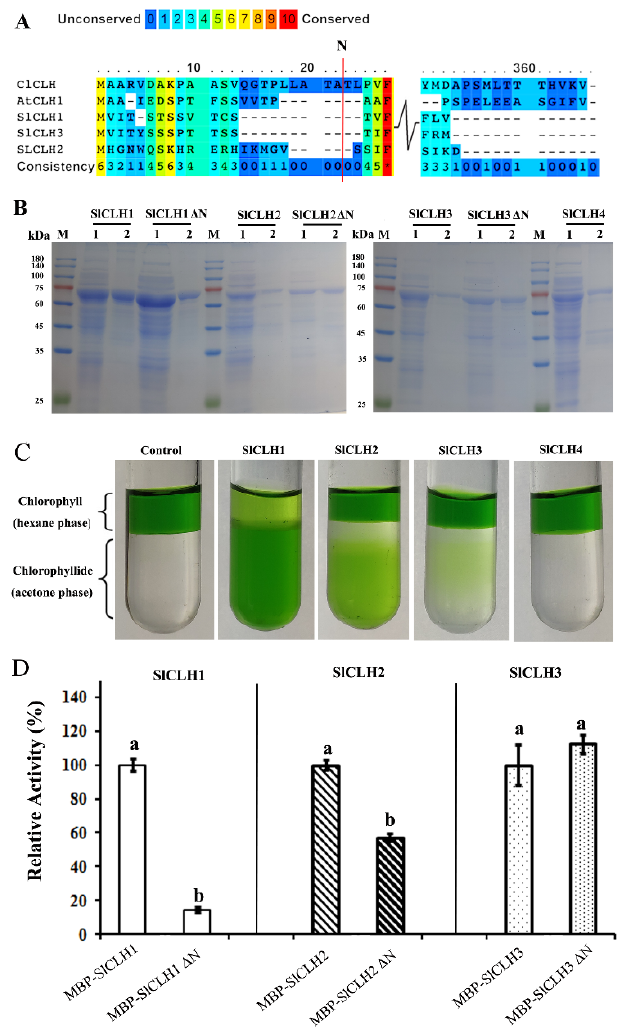
Figure 4. Effect of the predicted N-terminal processing sites on the activity of recombinant SlCLHs. ( A ) Alignment of partial N- and C-terminal amino acid sequences of SlCLHs with Arabidopsis thaliana ( AtCLH1 ) and Citrus limon ( ClCLH1 ). The putative N-terminal processing sites of SlCLHs are indicated by a red line. ( B ) SDS-PAGE analysis of N-terminally MBP-tagged recombinant SlCLHs and SlCLHs ∆ N. M, prestained molecular weight marker. Line 1, crude extract of recombinant SlCLHs. Lane 2, purified recombinant SlCLHs after amylose resin affinity column chromatography. The protein gel was stained with Coomassie Brilliant Blue. ( C ) Chlorophyll and Chlide were separated by